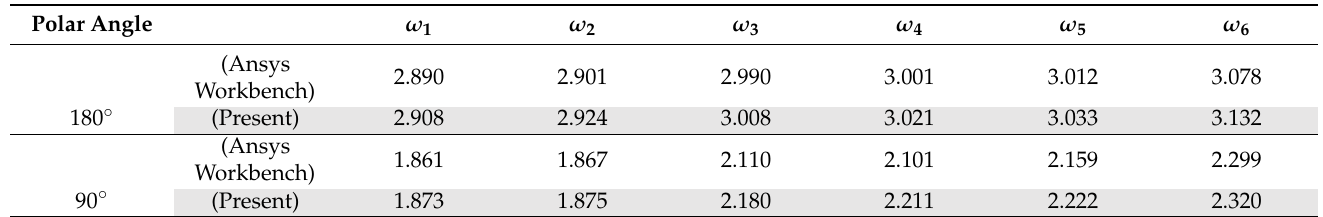
Table 2. Comparison of buckling loads between present study and Ansys